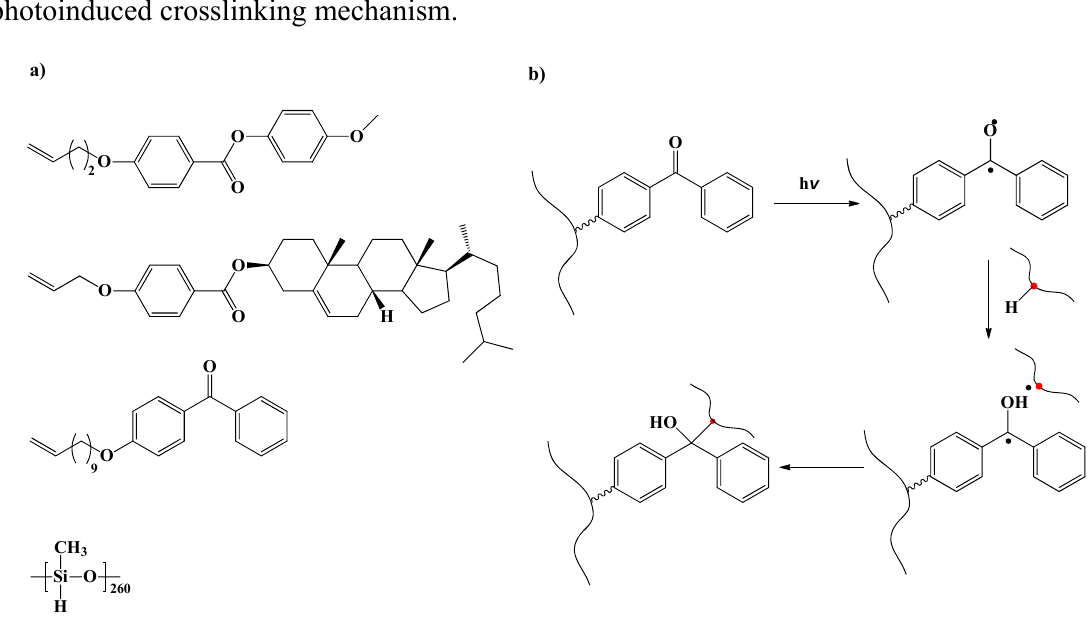
Figure 6. ( a ) Chemical structures of the molecules utilized for the synthesis of photo-crosslinked monodomain LCEs by Komp et al. [40]; ( b ) schematic representation of photoinduced crosslinking